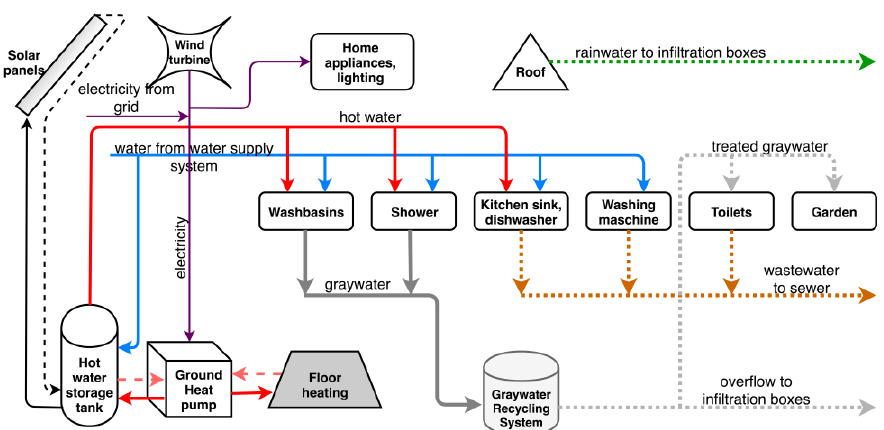
Figure 6. Diagram of system operation in Variant 3.